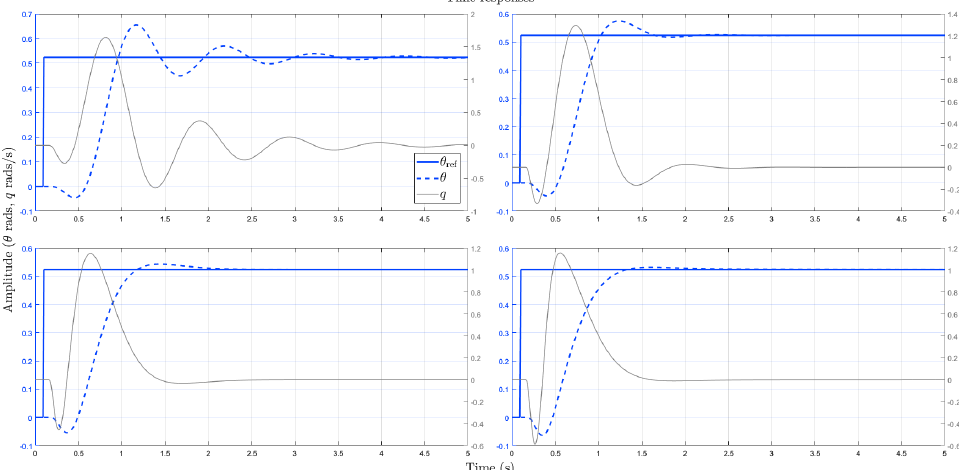
Figure 11. IMC–s time domain resp. (top-left, clockwise): τ c = 0.0675 s, 0.135 s, 0.54 s, 0.27